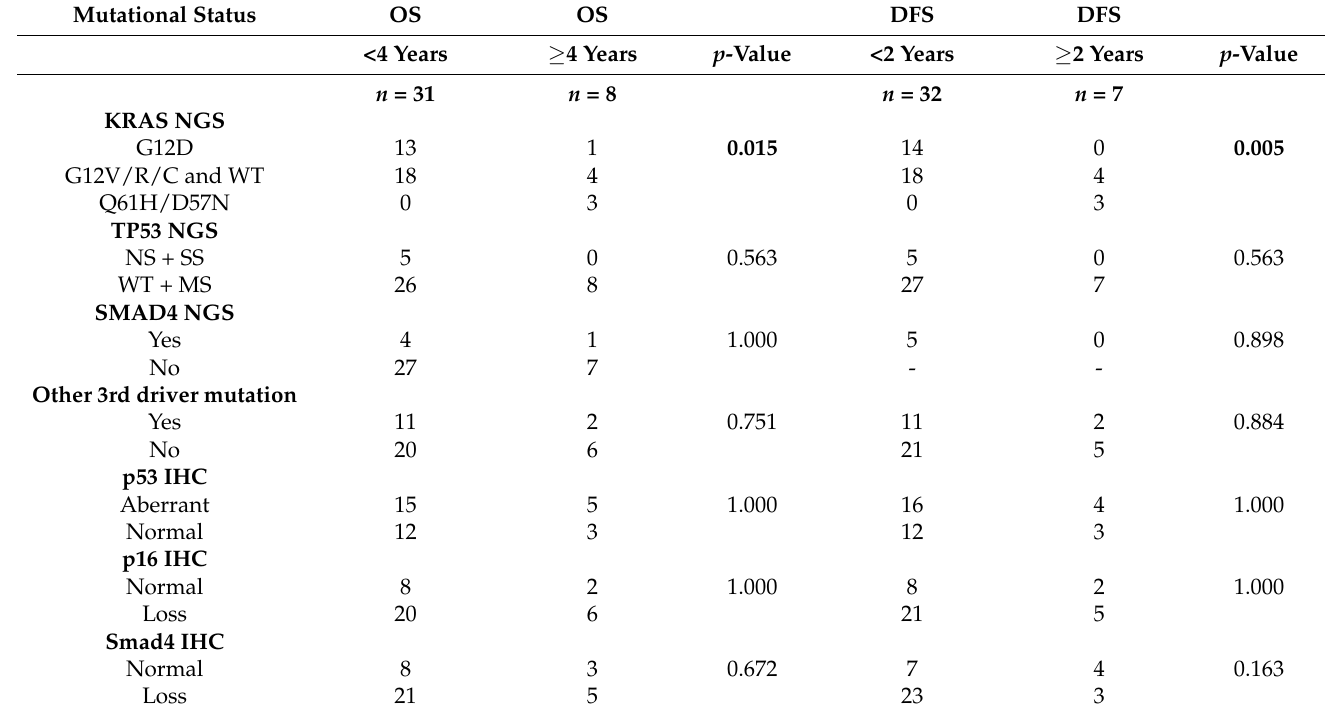
Table 3. Correlation analysis between survivor subgroups and oncogenic mutation; n = 39. Fisher’s exact test was used to test for significance ( p -value < 0.05 indicates significance).